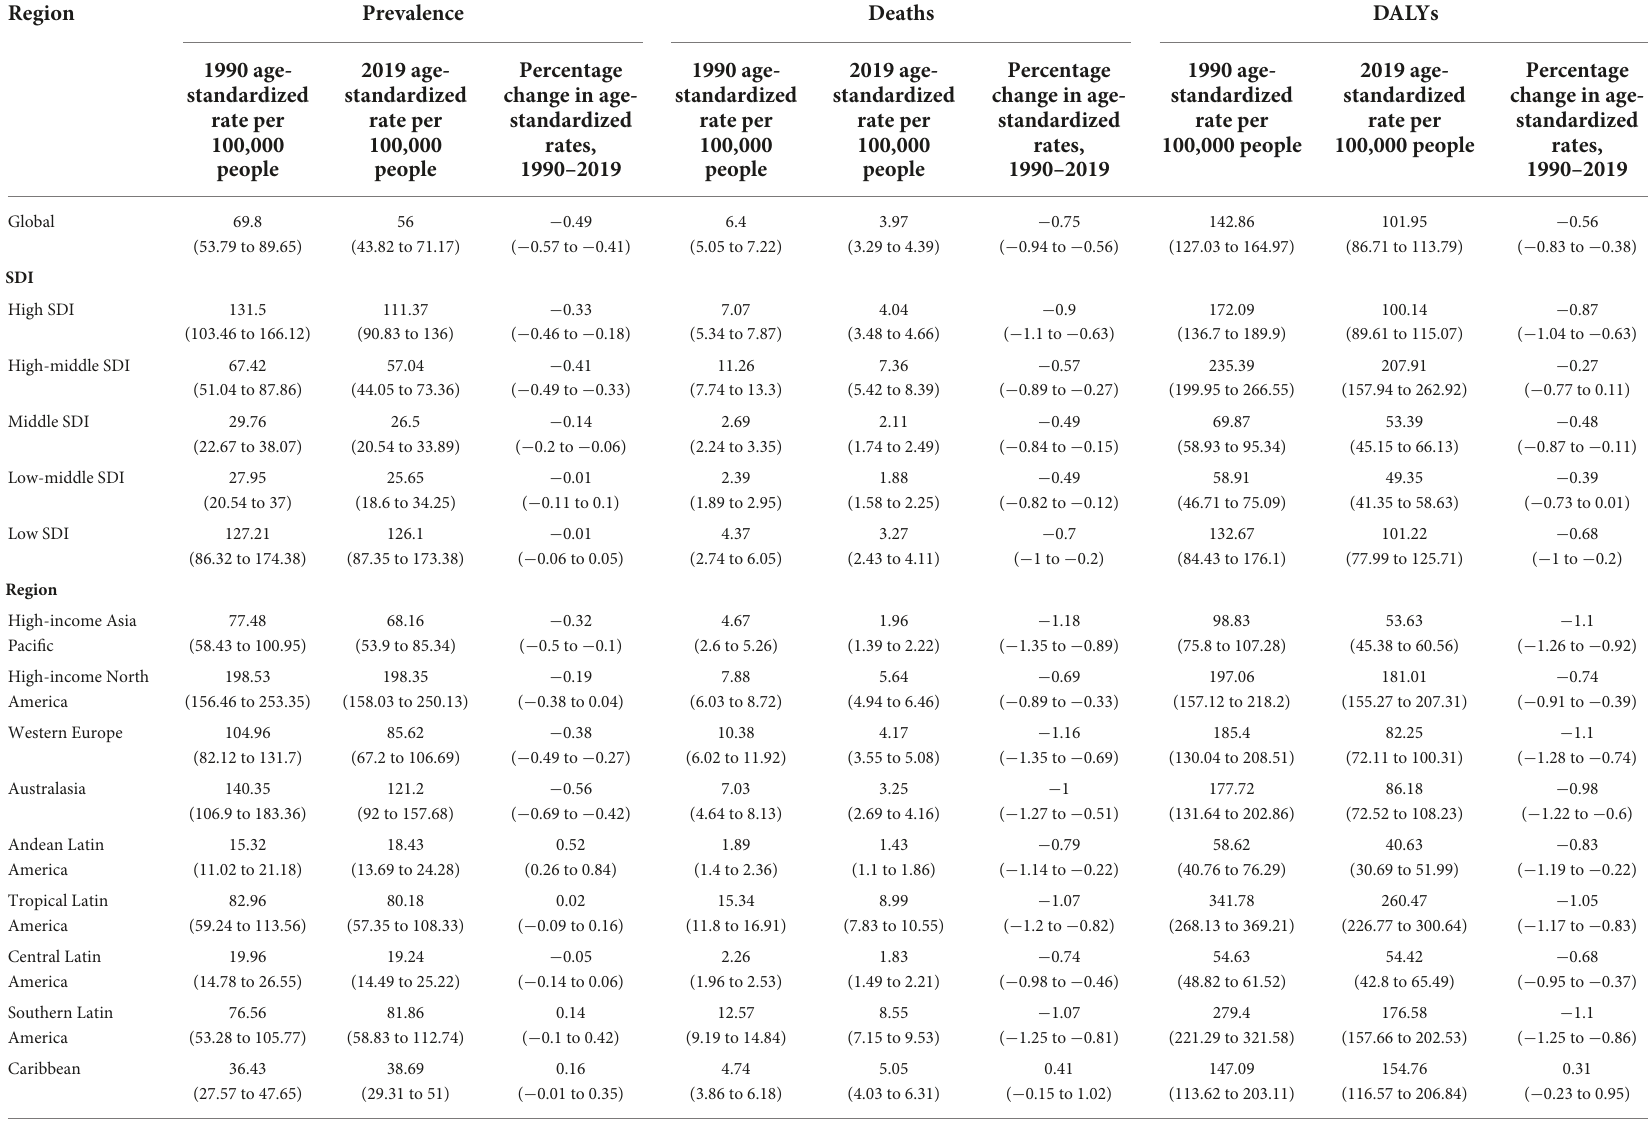
TABLE 1 Age-standardized prevalence, death, DALYs rates of the cardiomyopathy, and their percentage changes with 95% CIs from 1990 to 2019, both sexes.